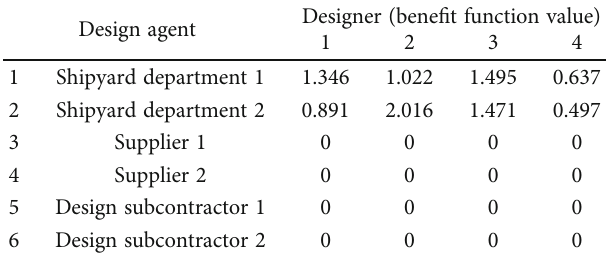
Table 15: Subtask T